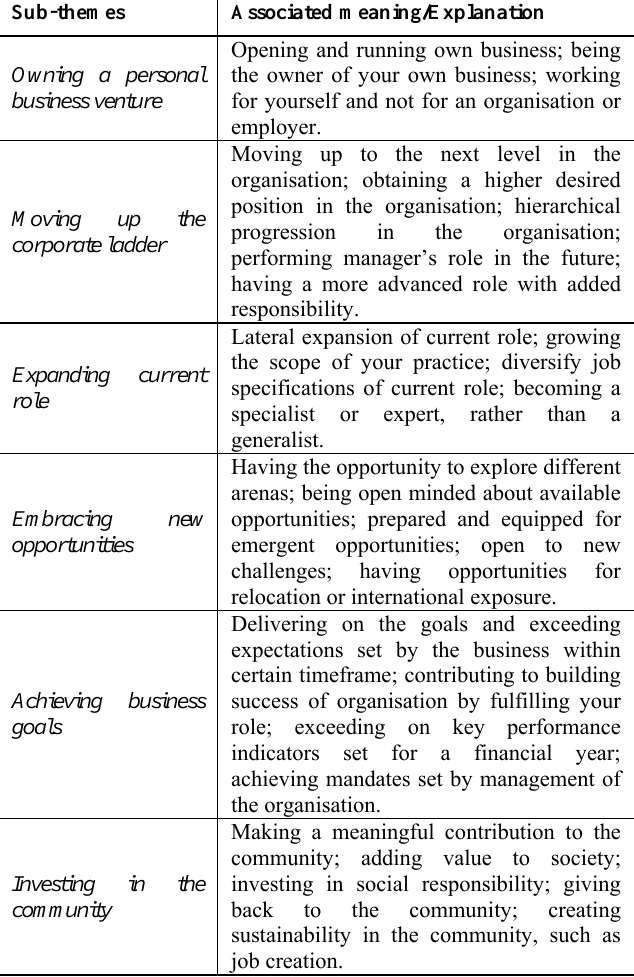
Table 3: Future goals of senior managers